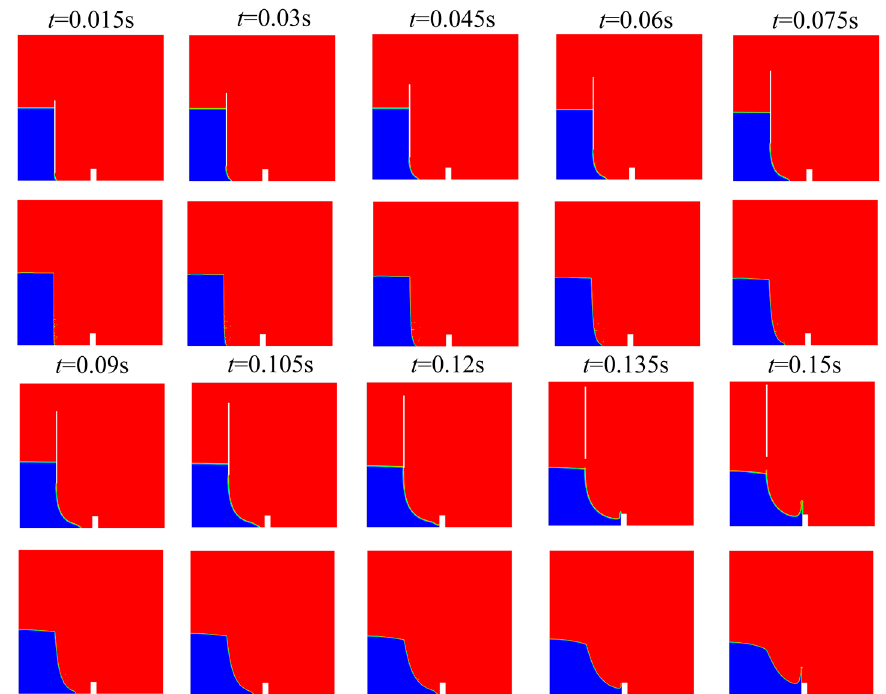
Figure 20. Free face comparison with and without gate.